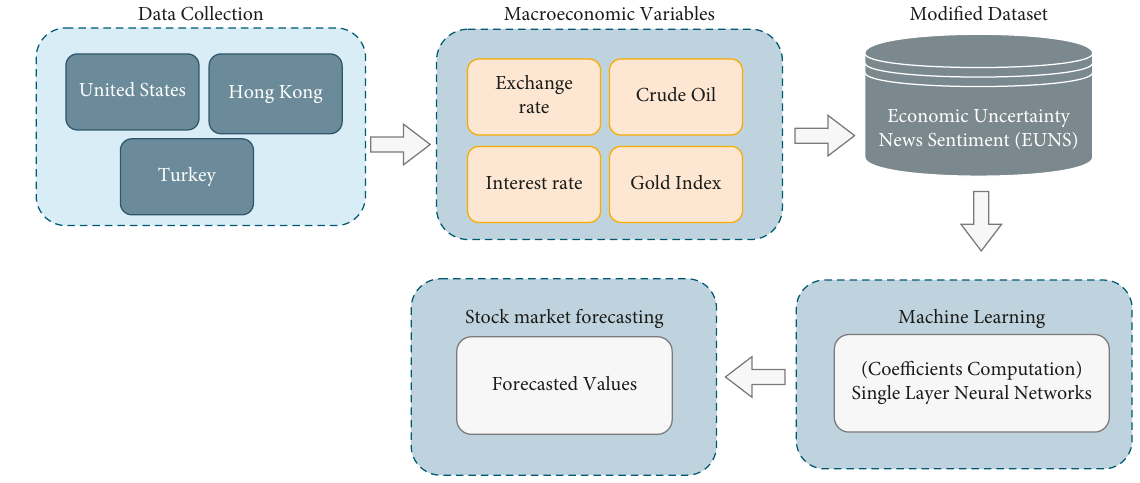
Figure 1: Overview of the proposed Table 1: Set of countries and companies in the analysis.